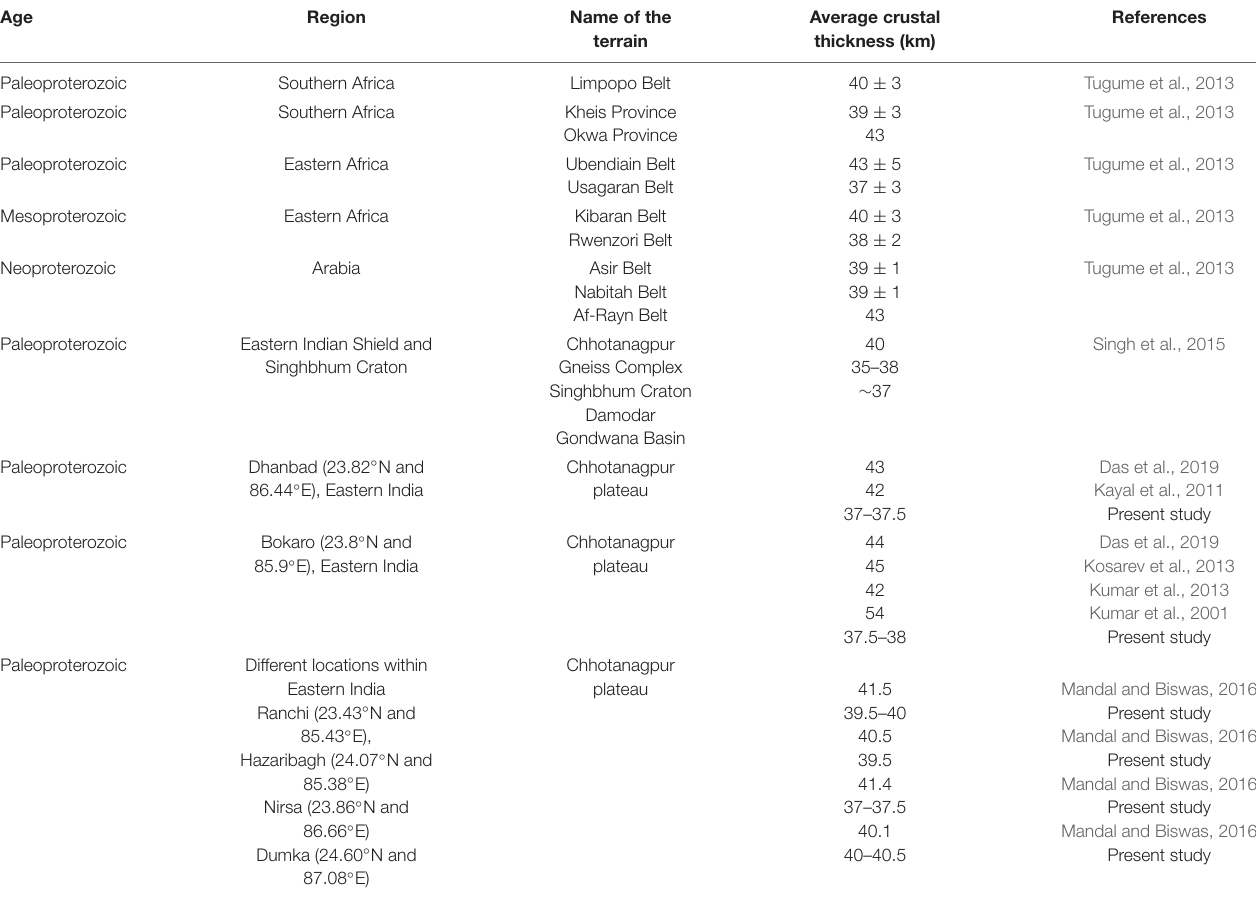
TABLE 4 | Thickness of the crust of different shield areas around the globe and the present study